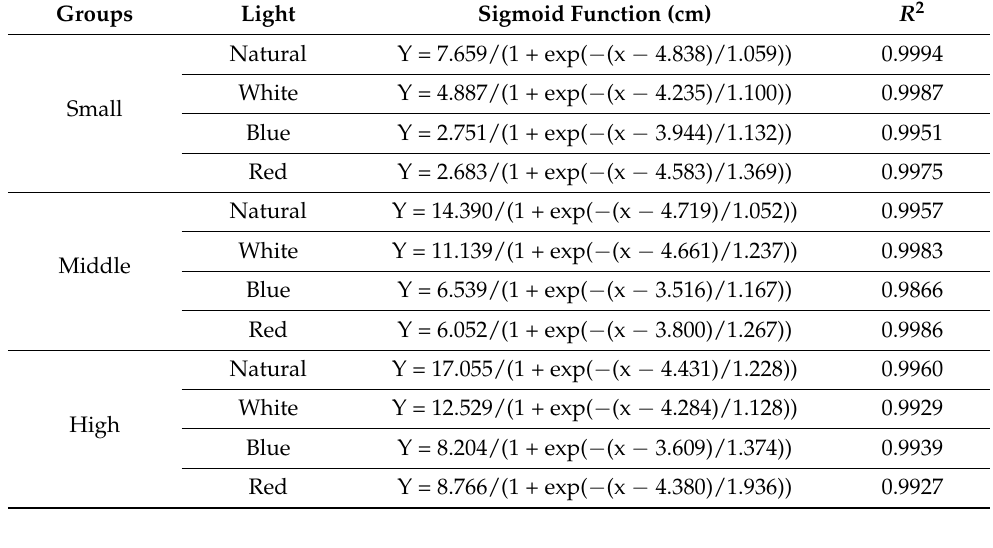
Table 4. Sigmoid function of the length of hypocotyl.